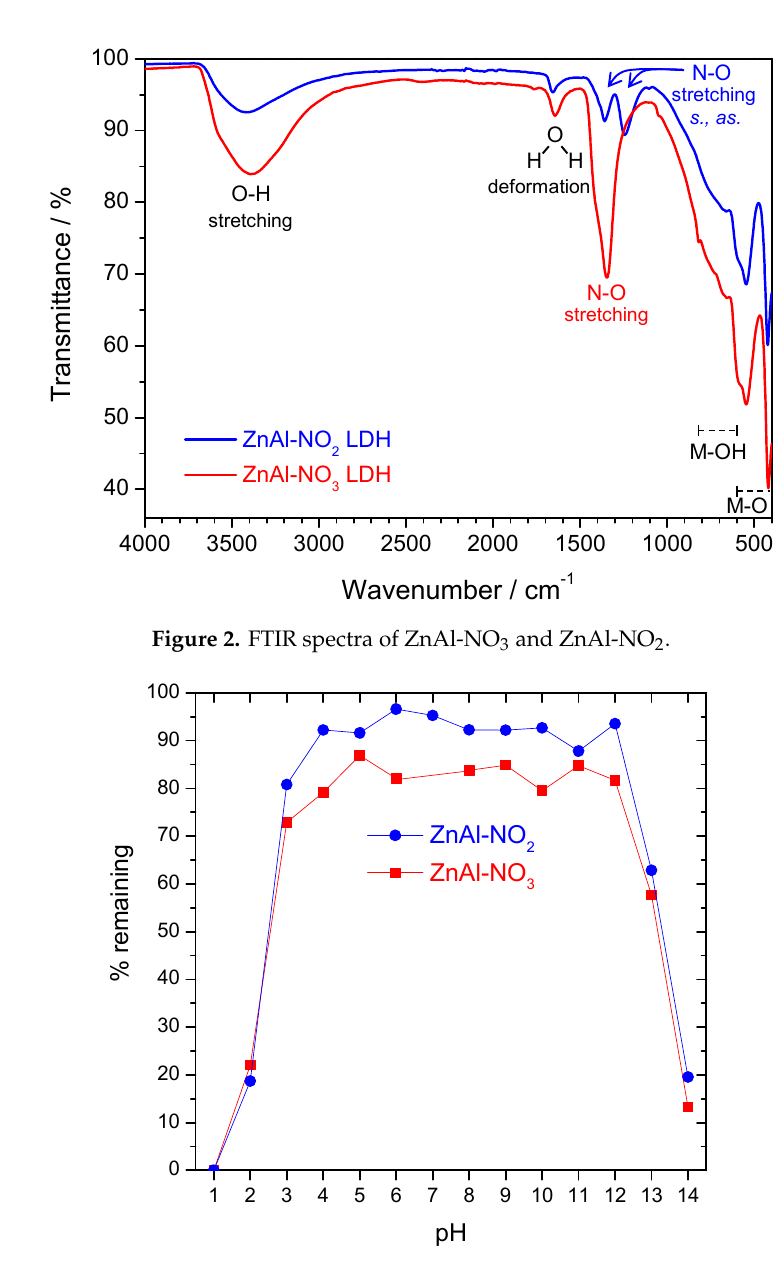
Figure 3. Mass (%) of undissolved LDH powder after 1 month of immersion in water in the pH range 1 to 14.